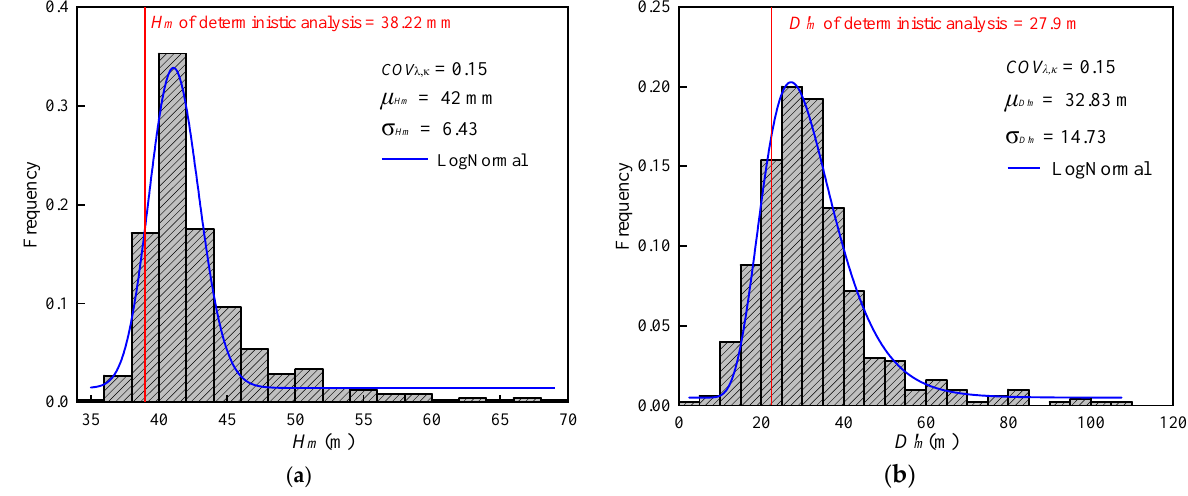
Figure 13. Histogram, fitting PDF curves, and statistics of H m and D ’ m : ( a ) H m ; ( b ) D ’ m .